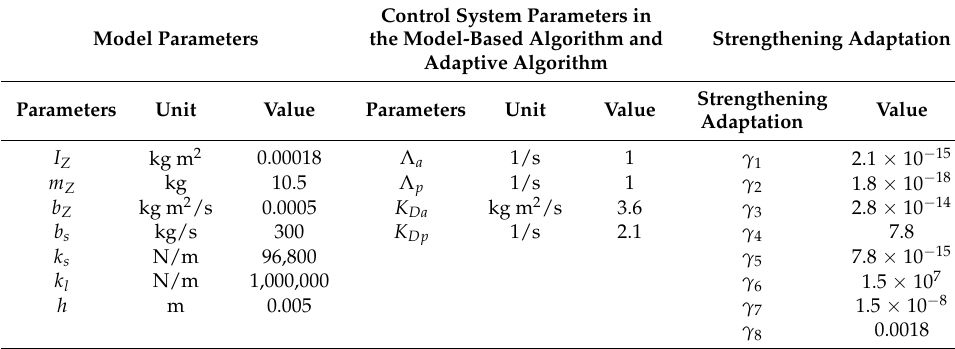
Table 1. Parameters of the model and of control systems used in simulation research. Control System Parameters in Model Parameters the Model-Based Algorithm